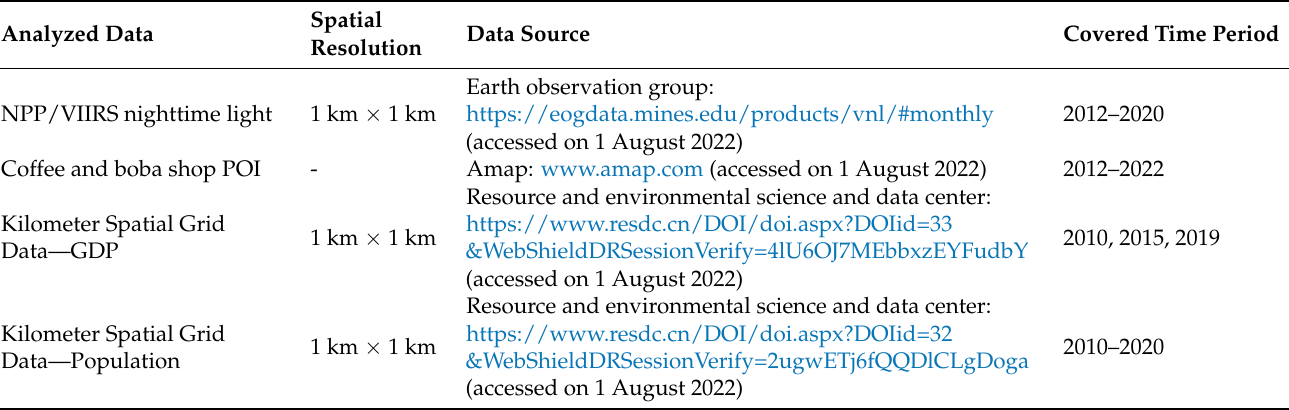
Table 3. Description and source of analyzed